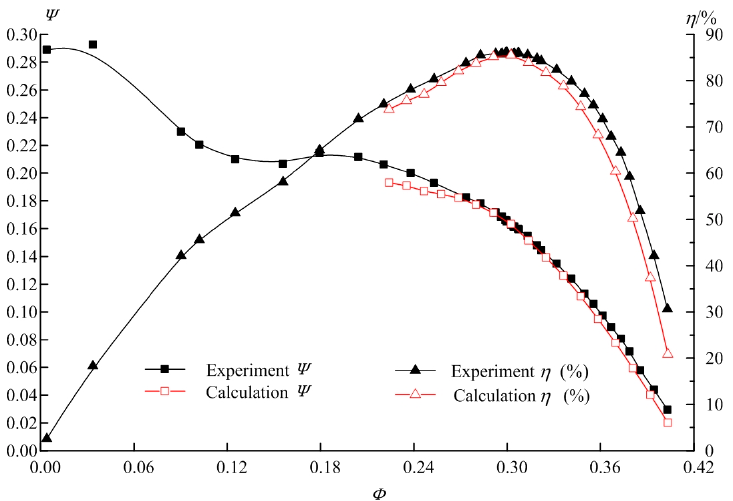
Figure 6. Comparison of pump performance between experiment and simulation.